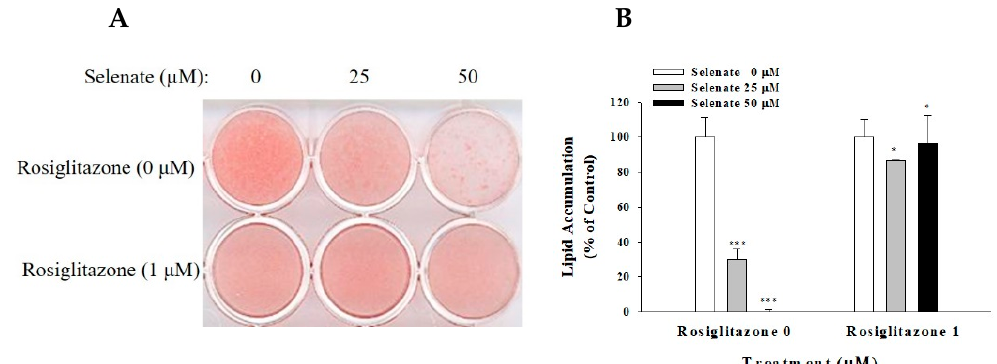
Figure 3. Rosiglitazone abolishes selenate-inhibited adipogenesis. After a 24 h pretreatment of one-day post-confluent 3T3-L1 preadipocytes with 50 µ M of selenate, the cell differentiation was initiated by the addition of an adipogenic cocktail with 0 or 1 µ M rosiglitazone during Day 0–2, in the absence of selenate. On Day 2, the cells were transferred to Dulbecco’s modified Eagle’s medium (DMEM) containing 10% fetal bovine serum (FBS-DMEM) and insulin, and to 10% FBS-DMEM on Day 4–6. At Day 6, Oil Red O staining was performed ( A ). The quantitative analysis of staining is shown in ( B ). The data represent mean ± SEM. The experiment was conducted three times ( n = 3–9). * p < 0.05; *** p < 0.001.